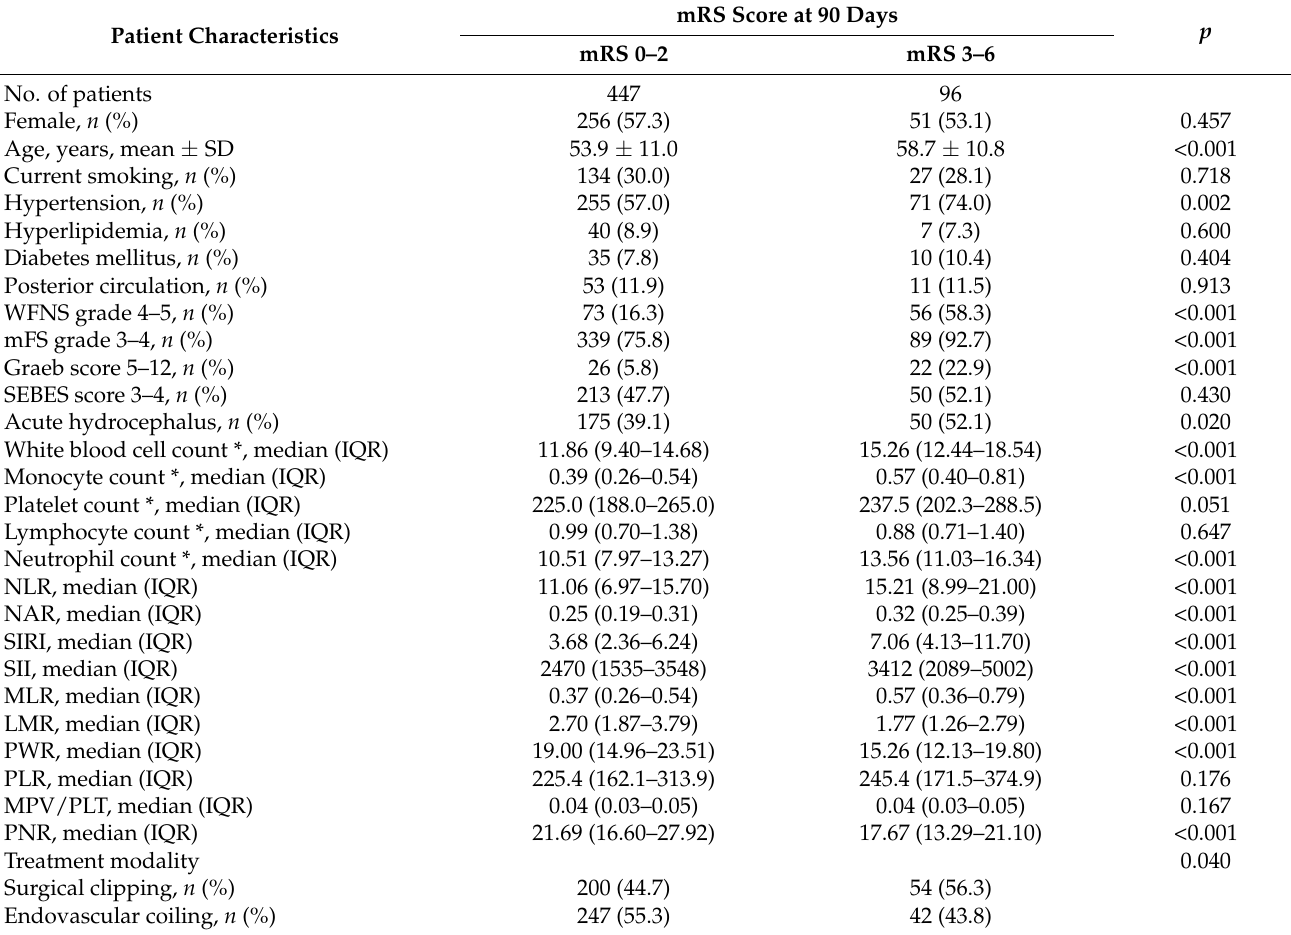
Table 1. Baseline